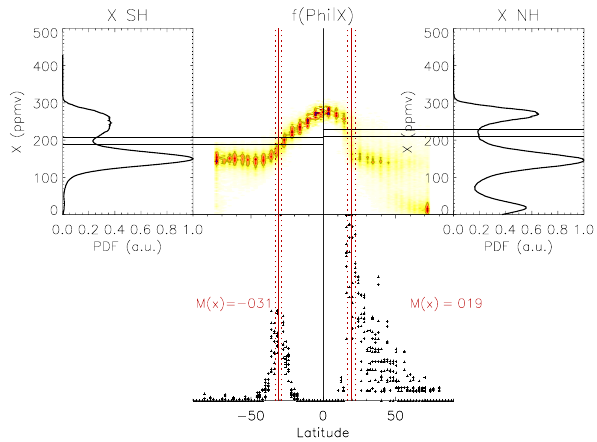
Figure A1. Schematic illustration of the derivation of the transport barrier positions from tracer PDFs for the example of the N 2 O dis- tribution from CLaMS for January 2010. The middle figure in the top row shows the PDF to find a certain N 2 O VMR at a certain lat- itude (colour coding; arbitrary units), i.e. P(φ | χ ), with latitude as horizontal and VMR as vertical axis. The top row shows the PDFs to find a certain VMR integrated over all latitudes – i.e. P(χ ) for the Northern Hemisphere (right) and the Southern Hemisphere (left). The horizontal double lines indicate the VMR range for the mini- mum of P(χ ) related to the subtropical mixing barriers, i.e. their values ± their uncertainties. In the lower panel, the latitude with the highest probability to find these mixing ratios is identified (indi- cated by the red vertical lines). The red dotted lines provide the uncertainty ranges determined by the uncertainties of the minimum VMRs. The red numbers indicate the latitudes of the barrier posi- tions